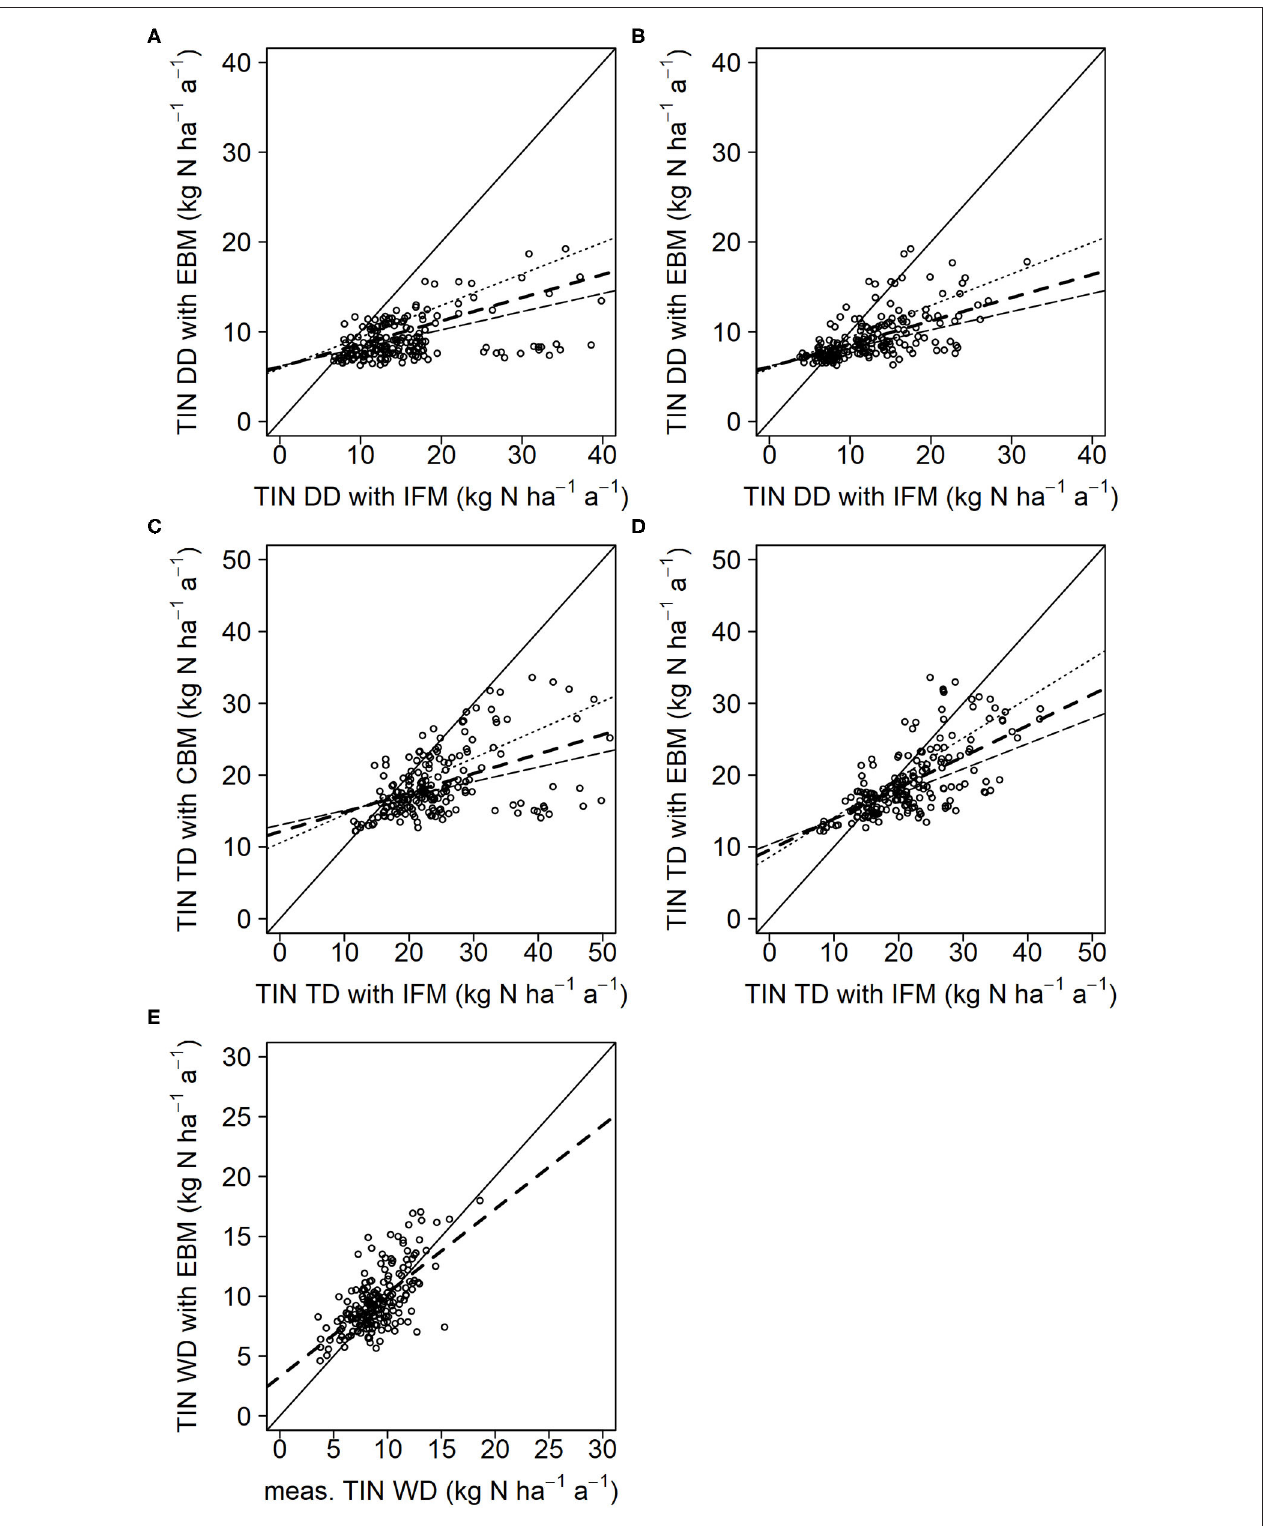
FIGURE 4 | Comparison of dry deposition (DD) (A,B) , total deposition (TD) (C,D) and wet deposition (WD) (E) of total inorganic nitrogen (TIN) between emission based (EBM) and inferential method (IFM) ( n = 194 site-years from 42 sites). (A,C) calculated with forest type specific deposition velocities; (B,D) calculated with site specific deposition velocities. The solid black line represents the 1:1 line and the dashed lines represents the linear regressions lines for vd mean (- - - -), vd min ( ···· ), and vd max (——–) (see also Table 2 ). For vd min and vd max only the regression lines were displayed and not the individual points. All statistical parameters are given in Table 6 .